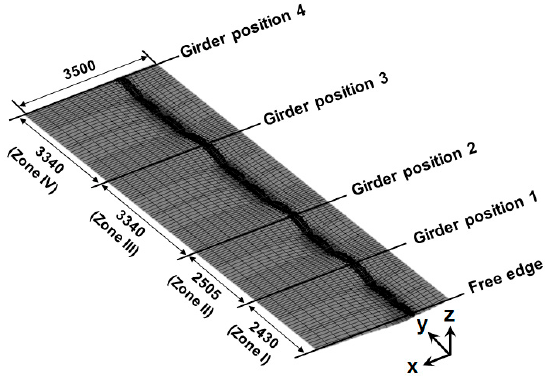
Figure 21. Deformed shape of upper plate (simulation 1).